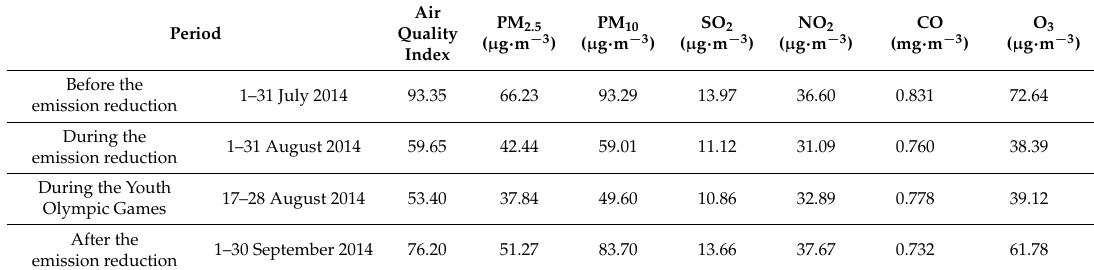
Table 2. Mean value of the AQI and mean air pollutant concentrations during the different